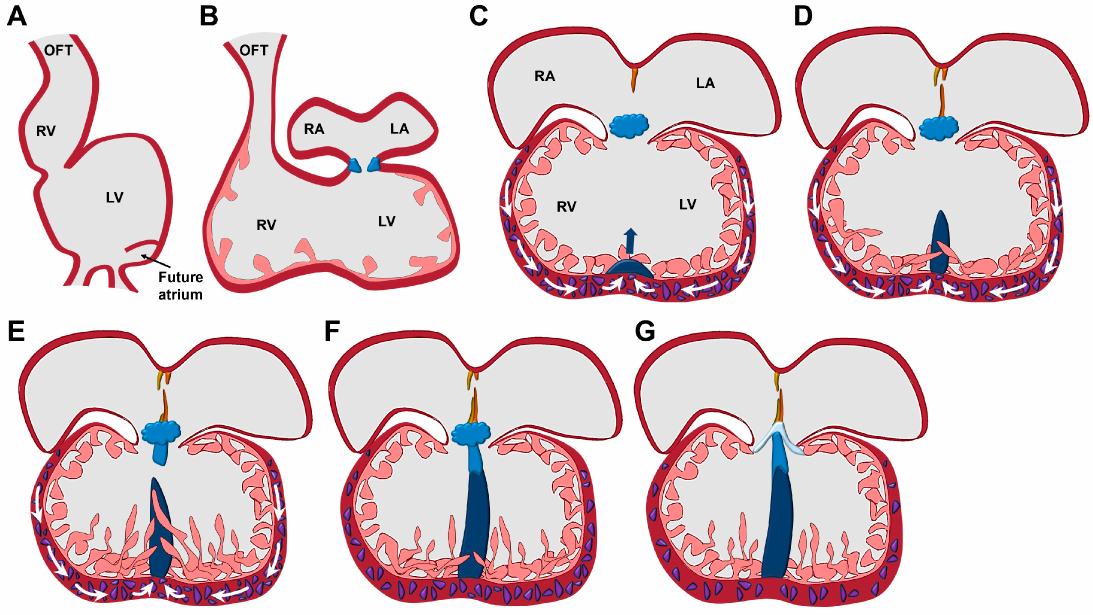
Figure 1. Development of the ventricular septum. ( A ) The linear heart tube balloons to give rise to precursor structures of the heart chambers. ( B ) The heart takes its four-chambered shape by a process termed heart looping. ( C ) Proliferating cells (in purple) of the ventricular walls lead to the outgrowth of the muscular ventricular septum (in dark blue). ( D ) In addition, trabeculae that are derived from the ventricular walls start to participate in the formation of the ventricular septum. ( E ) After a molecular interaction between the muscular ventricular septum and the endocardial cushion cells (in bright blue), the membranous ventricular septum develops from the endocardial cushion cells and grows towards the muscular ventricular septum. ( F ) Finally, the muscular and membranous ventricular septa fuse. ( G ) The atrioventricular endocardial cushion cells give rise to the atrioventricular valves. LA, left atrium; LV, left ventricle; OFT, outflow tract; RA, right atrium; RV, right ventricle.